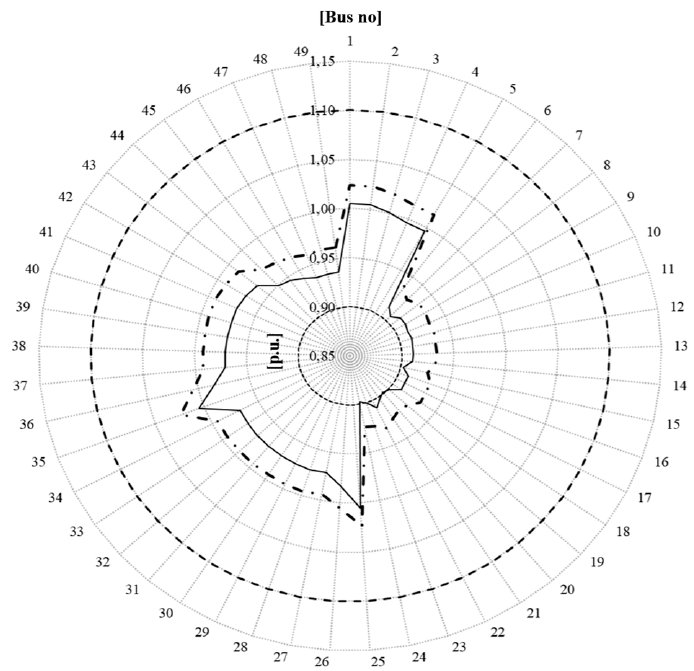
Figure 6. Network voltage profile with (dotted-dashed line) and without (solid line) the voltage controllers. Dashed lines refer to voltage limits.